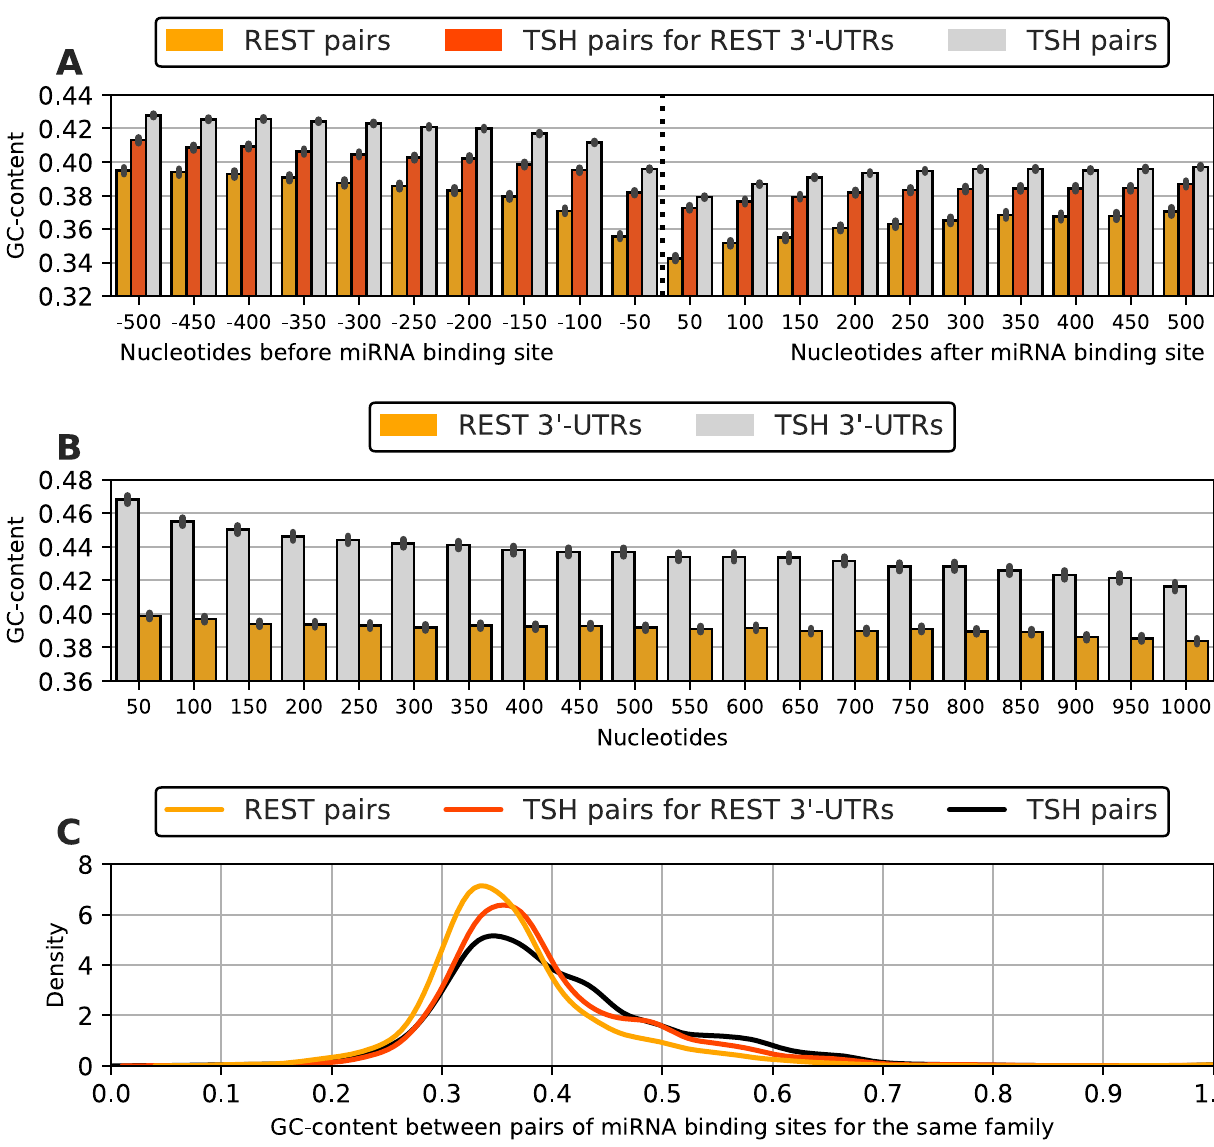
Fig 2. GC-content in the vicinity of predicted miRNA binding for subsets of miRNA-mRNA pairs. (A) GC-content relative to the distance around the miRNA binding site for REST pairs, TSH pairs and TSH pairs in the 3’-UTRs of REST regulated genes (TSH pairs in REST 3’-UTRs). (B) Background GC content for REST 3’-UTRs and TSH 3’-UTRs (see Methods for details). The error bars indicate the 99% confidence interval. (C) Kernel density estimation for the distribution of GC-content values between pairs of miRNA binding sites for the same miRNA family. Values obtained from TSH pairs, TSH pairs in REST 3’-UTRs and REST